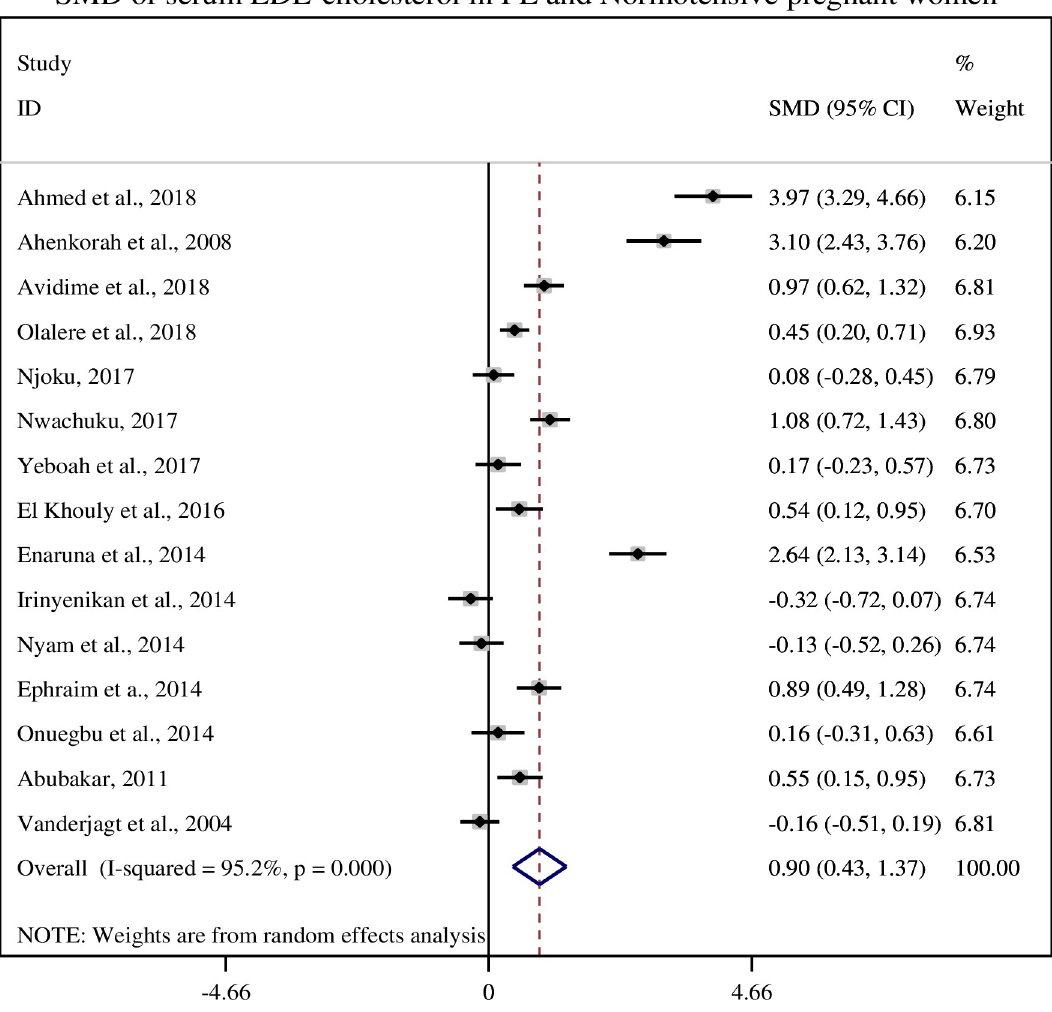
Fig 5. Forest plot of standardized mean difference of LDL-cholesterol and pre-eclampsia.